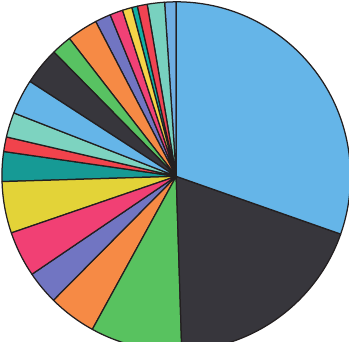
Figure 4: The functional predictions of proteins encoded in the genomes of MAG